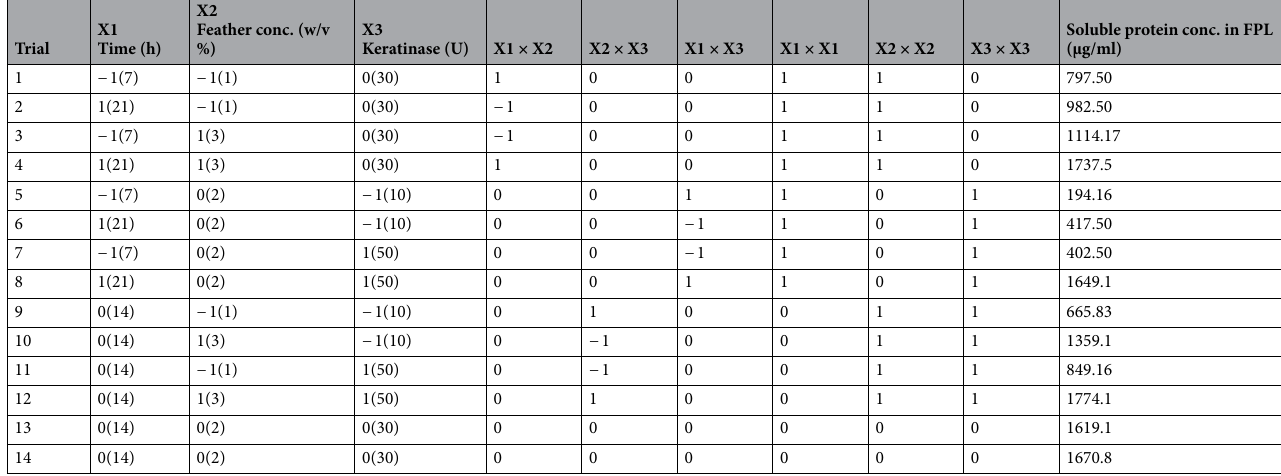
Table 1. BBD for the three selected variables with coded and real values; observed results for the released protein concentration in the enzymatically treated feathers. conc .